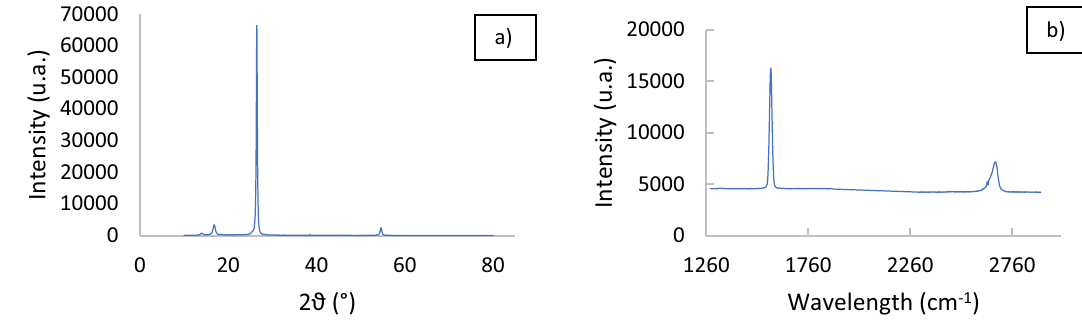
Figure 3. ( a ) difractogramm of TPEG, ( b ) Raman spectrum of TPEG.